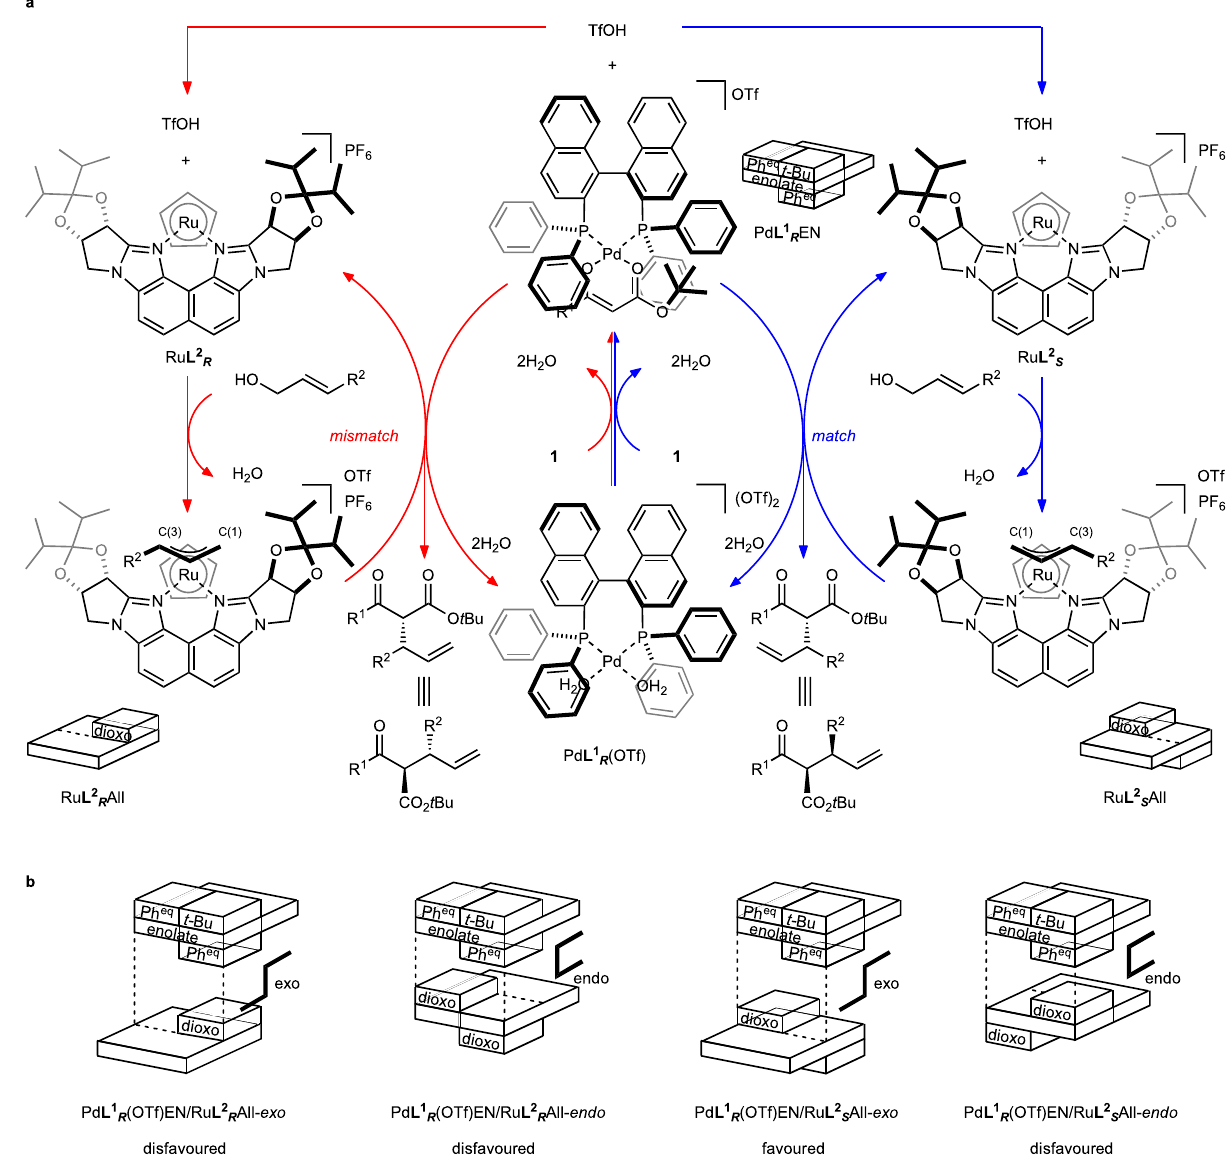
Fig. 3 | Proposed reaction mechanism. a Catalytic cycle of the matched (blue) and mismatched (red) systems using Pd L 1 R (OTf) complex with Ru L 2 S or Ru L 2 R complex. b Pattern diagram of nucleophilic addition for realizing the origin of diastereoselectivity. EN enolate ligand, All allyl